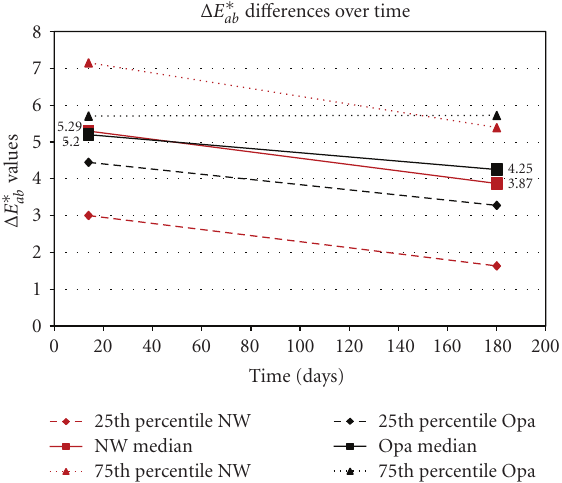
Figure 4: Opalescence (Opa) and Nite White (NW). The 25th percentile, median and 75th percentile di ff erences in the Δ E ∗ between the baseline (before treatment) and after treatment (14 days) and between baseline and after 6